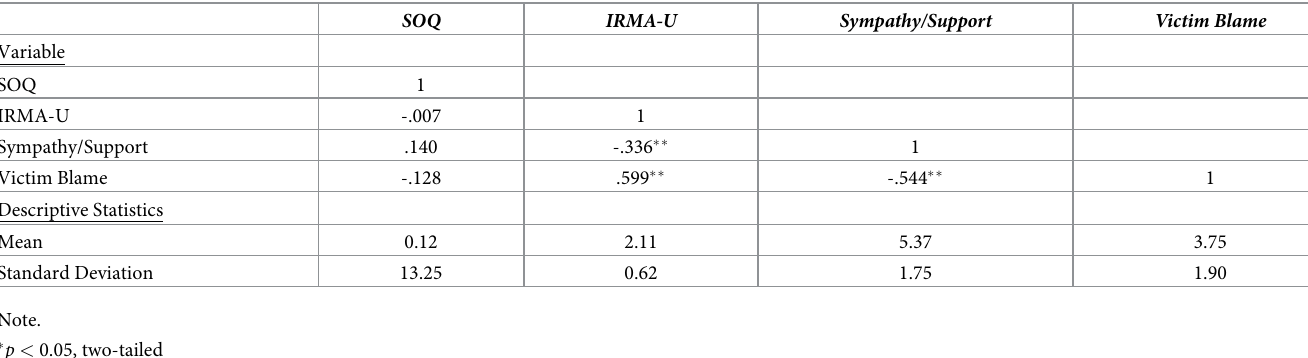
all the study variables’ means was conducted. They were all found to have a reasonably normal distribution, and correlations and descriptive statistics for the main variables can be found in Table 1. Hypothesis 1. To test hypothesis one, that participants who had higher levels of self-objec- tification would have lower levels of sympathy and support for a victim of rape and higher lev- els of victim blame, simple regression was employed. Self-objectification was expected to predict low sympathy and support in one model, and high victim blame in the second model. This hypothesis was not supported for victim blame regressed on self-objectification, b = -0.02, S . E . = 0.01, t = -1.76, p = 0.08. However, for the relationship between sympathy and sup- port and self-objectification, there was a significant effect, although this was not in the pre- dicted direction, b = 0.02, S . E . = 0.01, t = 1.93, p = 0.05. So, women who engaged in higher overall self-objectification showed more sympathy and support for the victim.